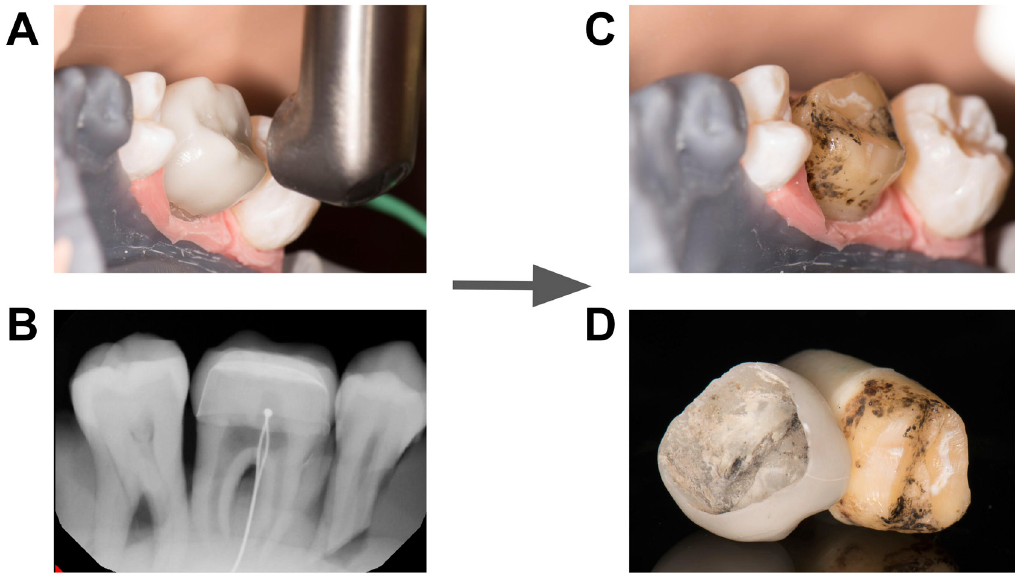
Figure 2. Laser-assisted crow removal. ( A ) Laser irradiation, ( B ) Radiograph showing temperature probe positioning, ( C ) Abutment after crown removal, and ( D ) crown and abutment specimens after crown removal.